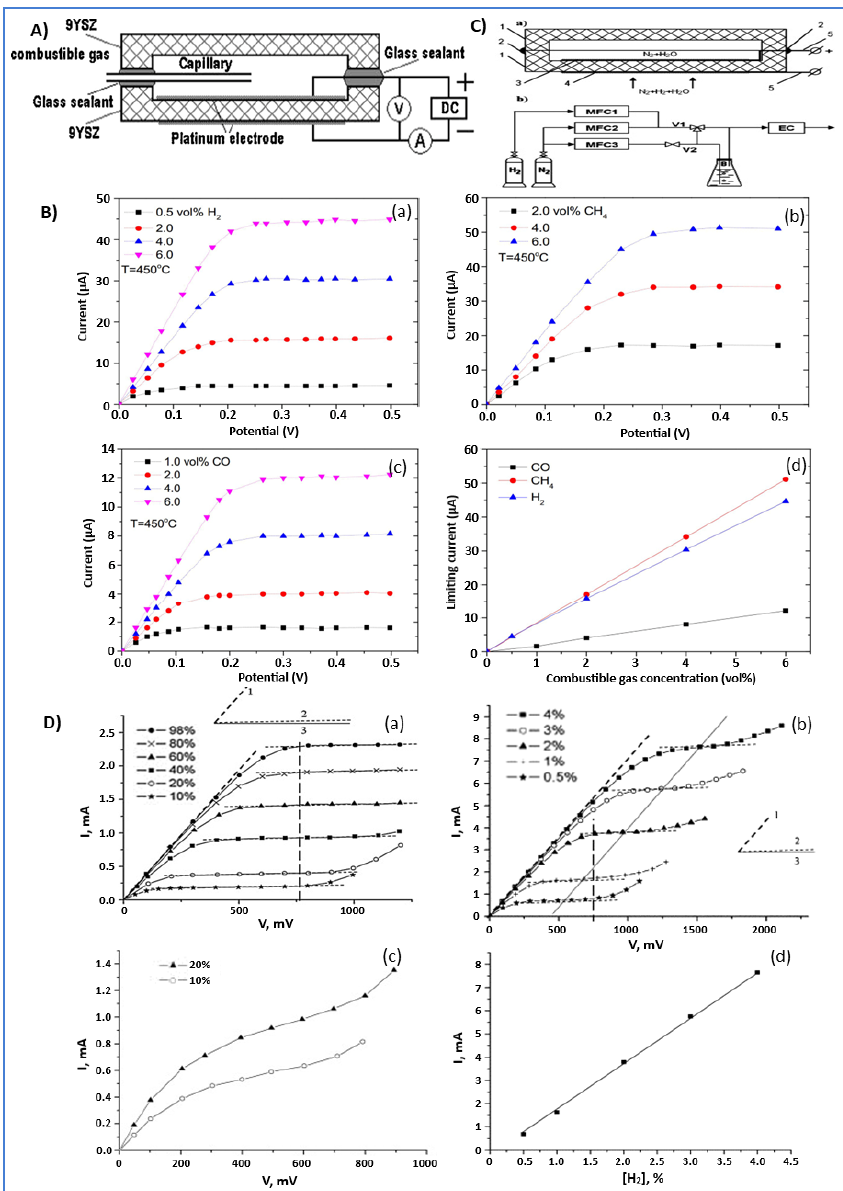
Figure 2. ( A ) Schematic representation of an amperometric sensor. Reproduced with permission from [50]. ( B ) I-V characteristic curves of the tested sensor at 450 ◦ C; (a) for the mixture N 2 + H 2 at different H 2 concentrations (0.5, 2, 4, 6 vol.% H 2 ); (b) for the mixture N 2 + CH 4 for different CH 4 concentrations (2, 4, 6 vol.% CH 4 ); (c) for the mixture N 2 + CO for different CO concentrations (1, 2, 4, 6 vol.% CO); (d) the relation between the limiting current and different concentrations of the three tested combustible gases (H 2 , CH 4 , and CO). Reproduced with permission from [50]. ( C ) Schematic representation of the amperometric sensor, (1) proton-conducting electrolyte, (2) glass sealant, (3–4) Pt electrodes, and (5) platinum lead. Reproduced with permission from [51]. ( D ) I-V curves for (a) La 0.95 Sr 0.05 YO 3 electrolyte-based cell, (b) CaZr 0.90 Sc 0.1 O 3 electrolyte-based cell, (c) CaTi 0.95 Sc 0.05 O 3 electrolyte-based cell, for different H 2 concentrations in mixtures of N 2 + 2%H 2 O + H 2 at operating temperature of 800 ◦ C, and (d) dependence of limiting current on hydrogen content for cell-1. Reproduced with permission from